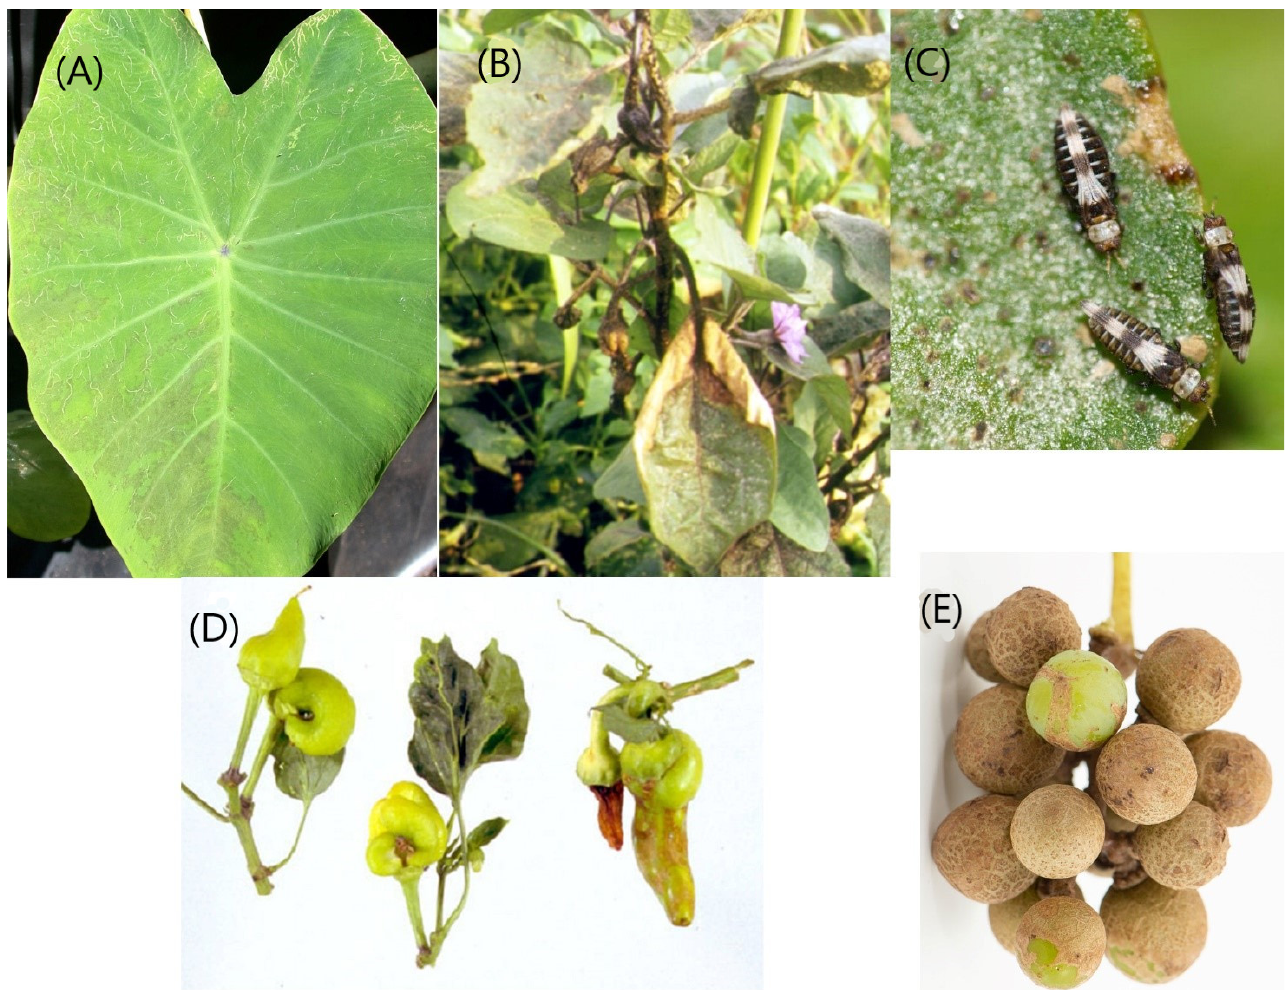
Figure 3. Feeding damage by thrips. ( A ) Biltothrips minutus markings on leaf of Taro ( Colocasia esculenta ). ( B ) Thrips palmi damage to aubergine crop ( Solanum melongena ). ( C ) Dendrothrips ornatus on Ligustrum leaf. ( D ) Damage to Capsicum fruits by Franklliniella occidentalis and Orthotospovirus. ( E ) Surface damage to grapes ( Vitis vinifera ) by Scirtothrips dorsalis .